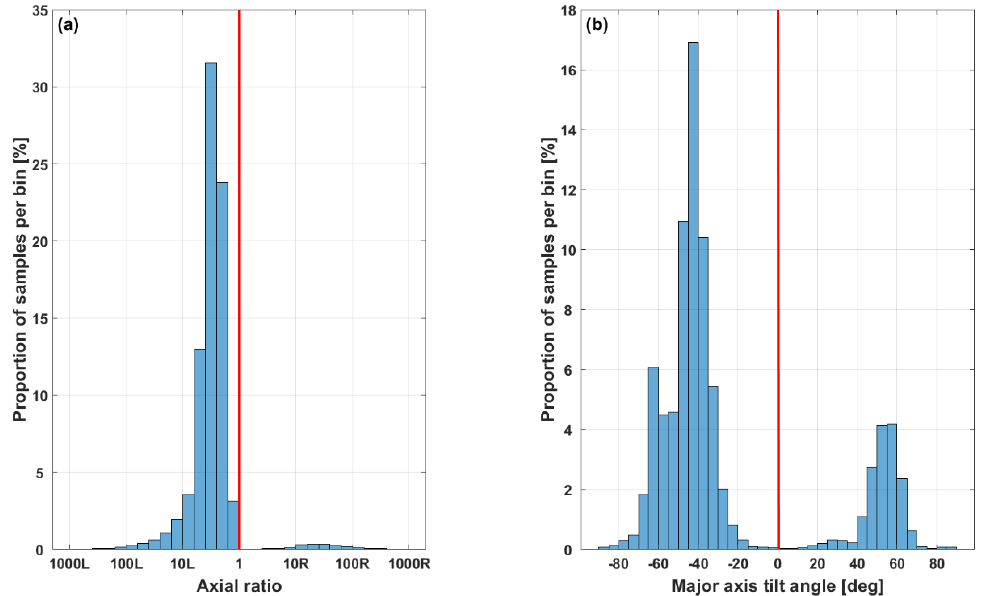
Figure 10. Slovenia: 29 July, 15, 18, 20 August 2018, total 23.4 min at 6000 samples s − 1 . ( a ) Axial ratio histogram. Horizontal axis: axial ratio (logarithmic scale). Red center line: axial ratio = 1 (circular polarization). Left of center line: left ‐ hand elliptical polarization. Right of center line: right ‐ hand elliptical polarization. Vertical axis: proportion of samples per bin. ( b ) Tilt angle histogram. Horizontal axis: tilt angle (linear scale). Red center line: tilt angle = 0° (horizontal). Left of center line: negative tilt angle. Right of center line: positive tilt angle. Vertical axis: proportion of samples per bin.